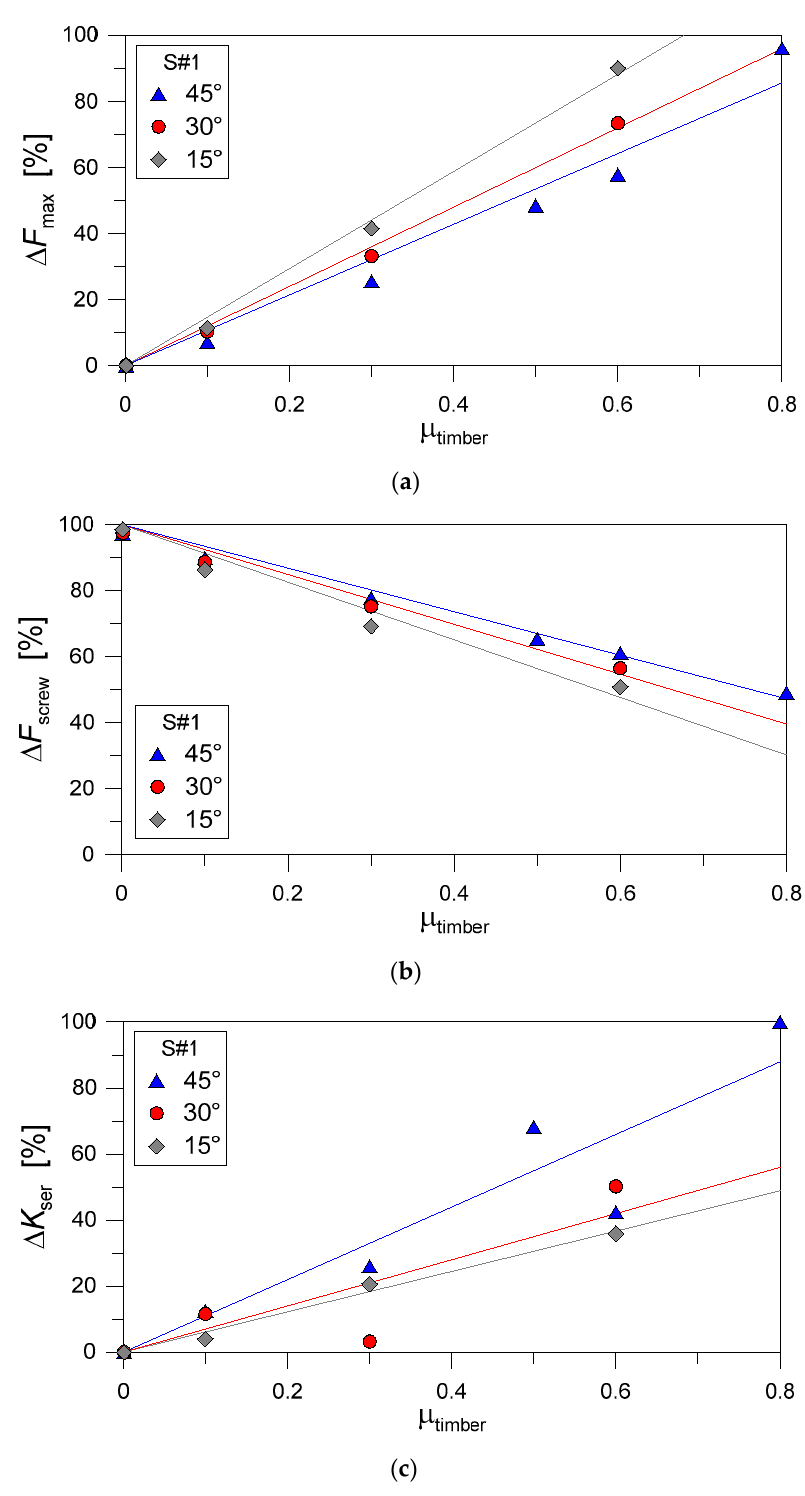
Figure 20. Percentage variation (Equation (4)) of performance indicators for TTC joints with inclined STSs, as a function of the timber-to-timber friction coefficient (S#1 joints under shear-compression): ( a ) maximum force; ( b ) load-bearing contribution of the STSs and ( c ) serviceability stiffness (ABAQUS/Explicit).